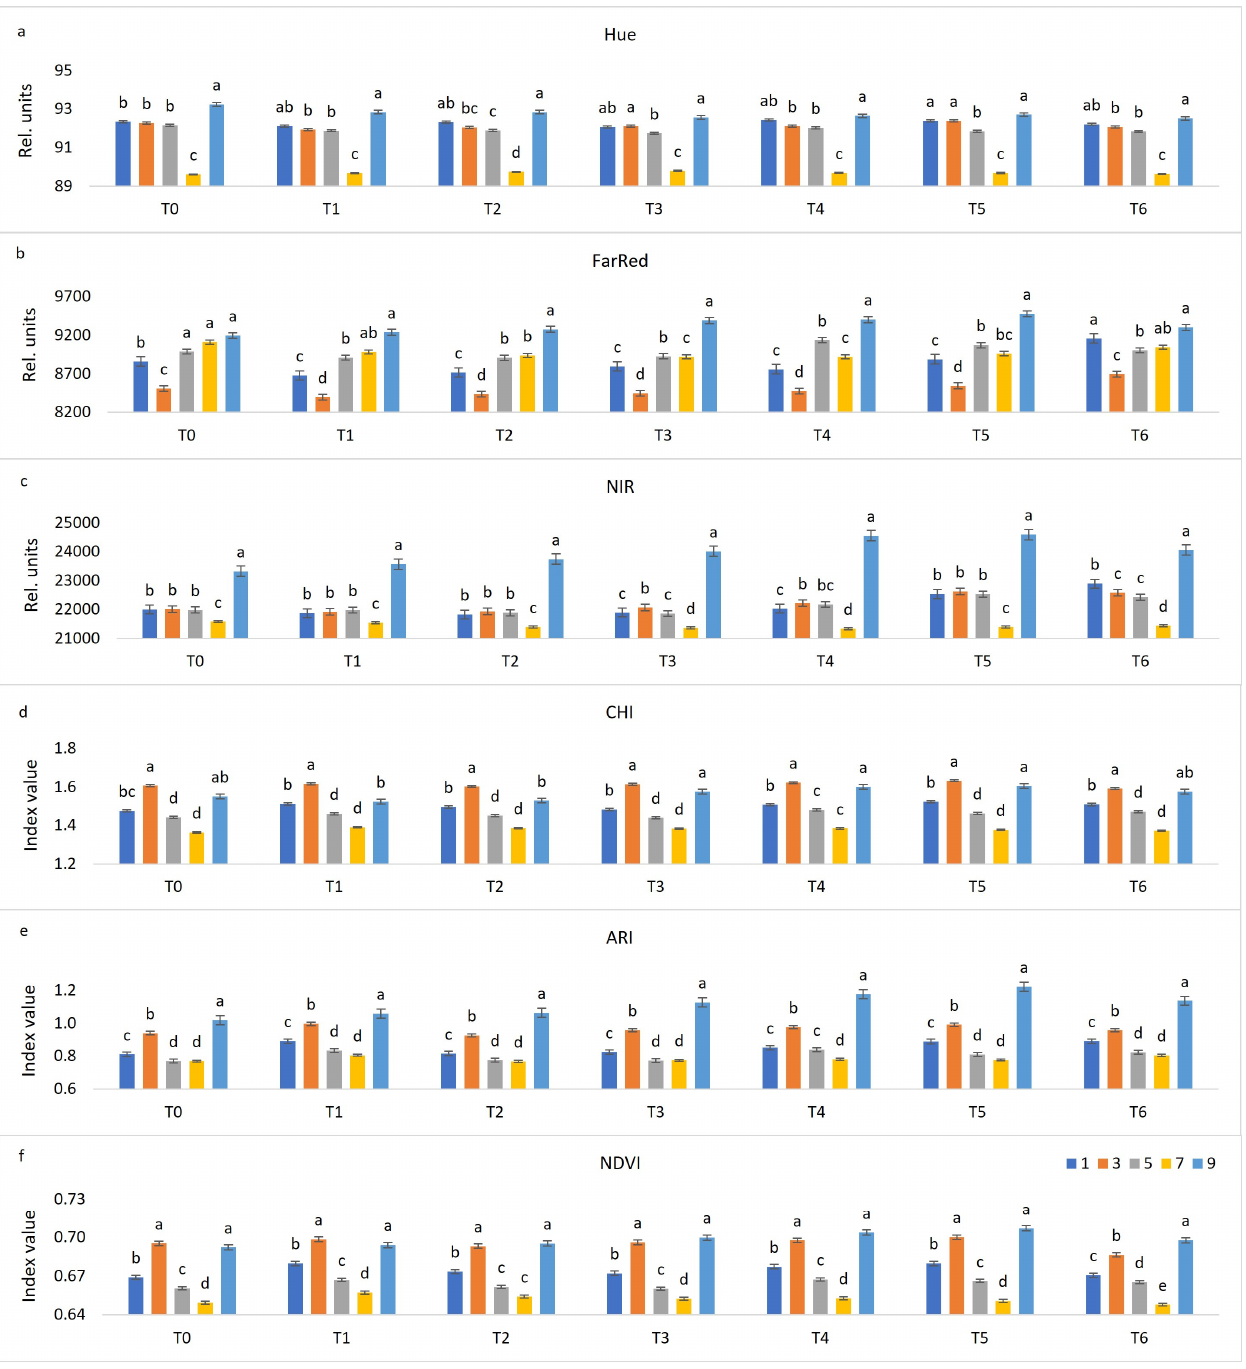
Figure 5. Changes between distinctive OIV classes (1 – most susceptible; 9 – resistant) throughout seven terms (before treatment (T 0 ), one day post-inoculation (dpi) (T 1 ), two dpi (T 2 ), three dpi (T 3 ), four dpi (T 4 ), six dpi (T 5 ) and eight dpi (T 6 )) in multispectral parameters. Differences between the means were evaluated by Duncan’s multiple range test at a confidence level of 95% ( p < 0.05). Means with the same letter are not significantly different. Sub-figures depict parameters as follows: ( a ) Hue, ( b ) FarRed, ( c ) NIR, ( d ) CHI, ( e ) ARI, and ( f ) NDVI.